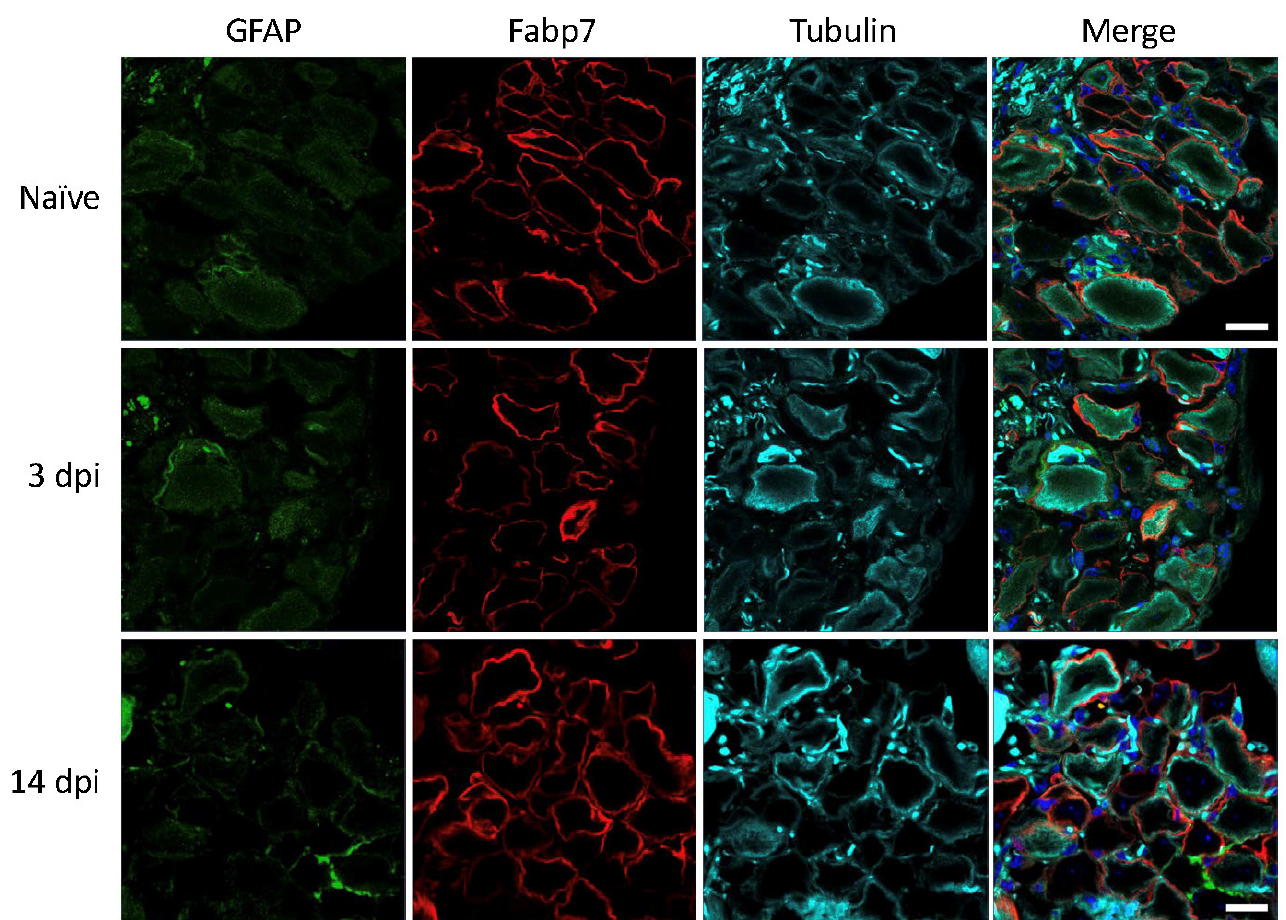
Figure 4. Mouse lumbar DRG 3- and 14-days post injury (dpi). GFAP (green), SGC marker Fabp7 (red), neuronal β -tubulin (magenta), and Hoechst nuclear marker (dark blue, merge only). Scale bar = 20 μ m.